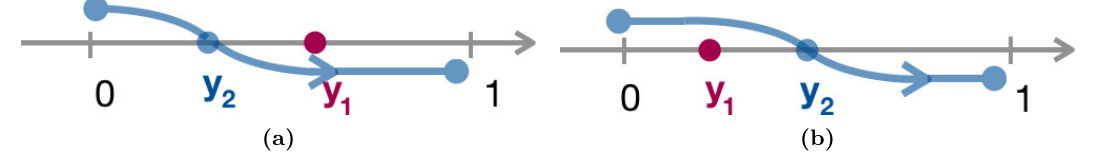
Figure 3. The contours corresponding to V 1 V 2 and V 2 V 1